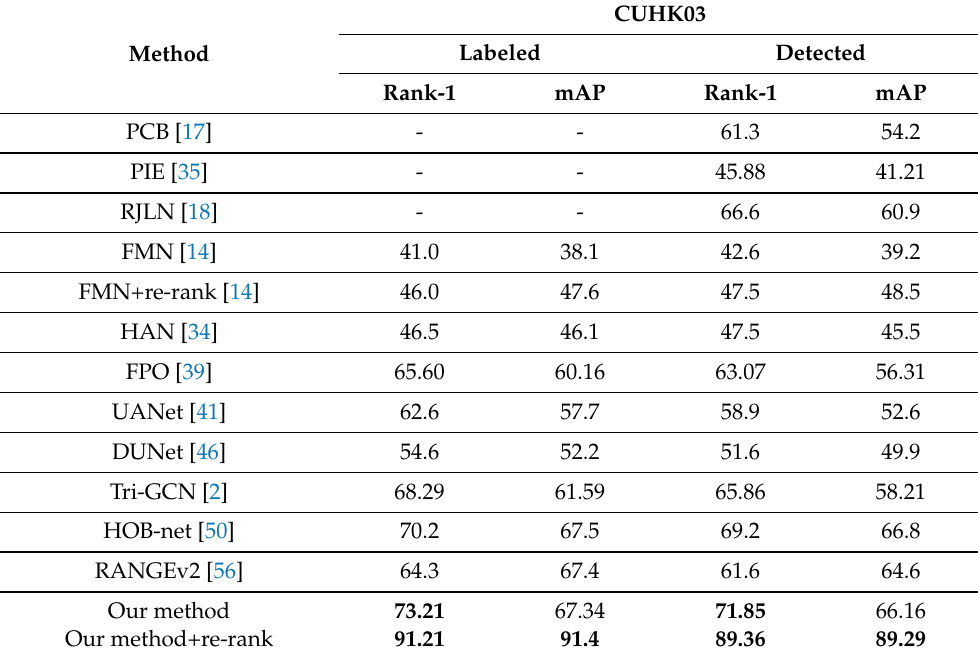
Table 4. Network technical change comparison on the CUHK03 dataset (labeled and